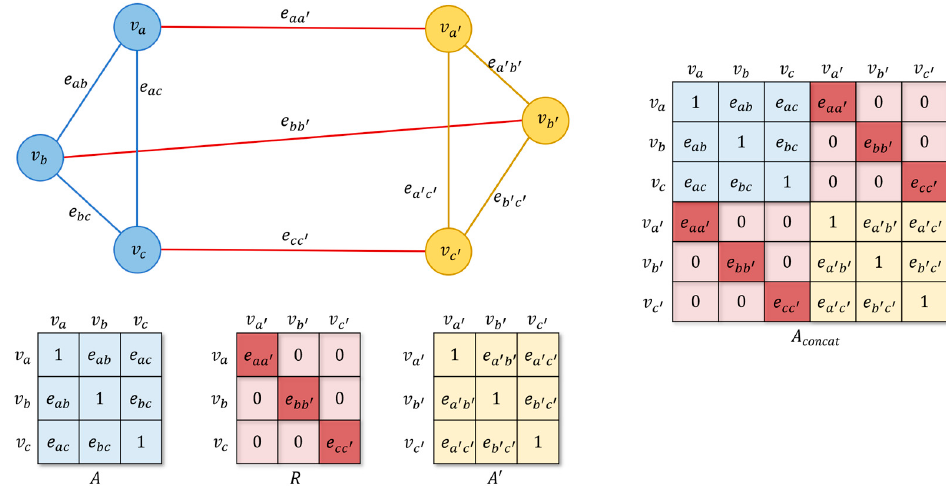
Figure 1. The schematic of the fusion of two subgraphs. Two subgraphs and their adjacency matrix of different FC are represented as blue (subgraph1 and 𝐴 ) and yellow (subgraph2 and 𝐴 (cid:4593) ). 𝐴 and 𝐴 (cid:4593) are the adjacency matrices within subgragh1 and subgraph2, respectively. The edges between the nodes from different subgraphs are colored in red. 𝑅 is the relational matrix between the two subgraphs. 𝐴 (cid:3030)(cid:3042)(cid:3041)(cid:3030)(cid:3028)(cid:3047) is the adjacency matrix of the new graph obtained by concat-fusion.